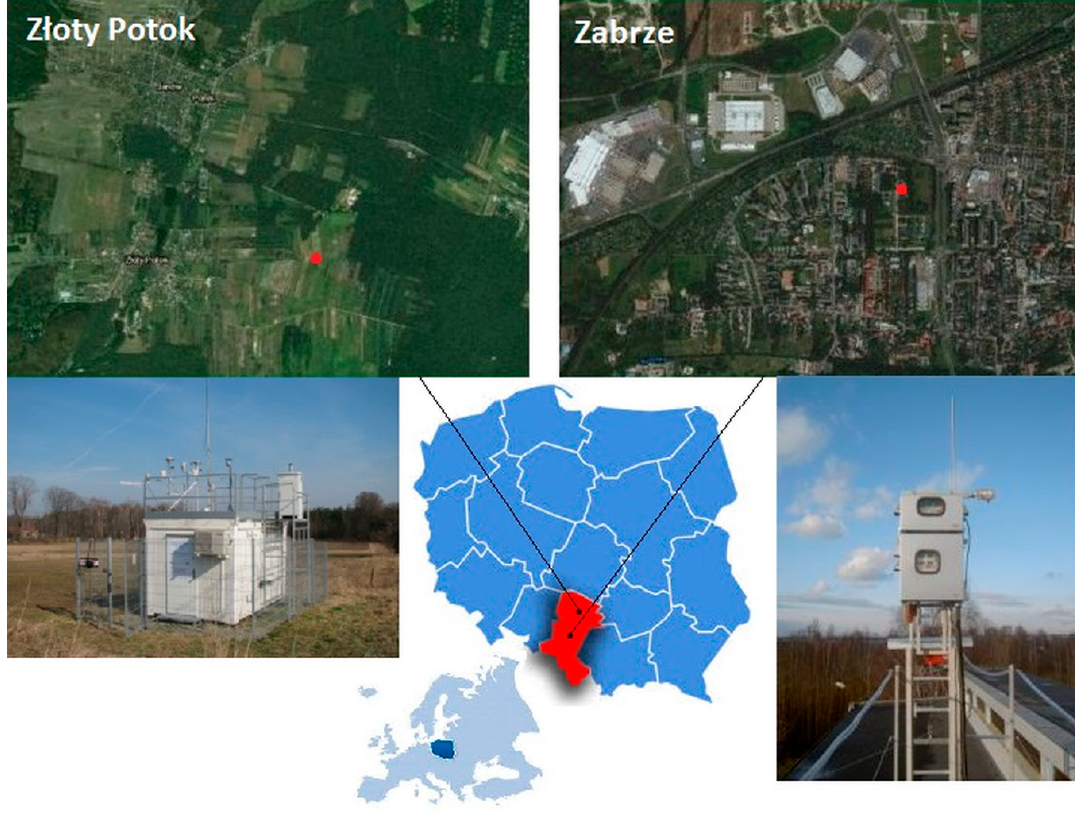
Figure 1. The location of measuring stations in Zabrze and Z ł oty Potok.